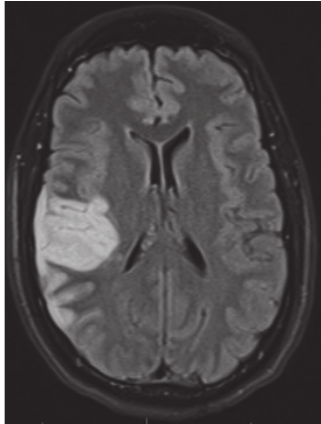
Figure 3: MRI of the brain with acute ischemic infarct in the right